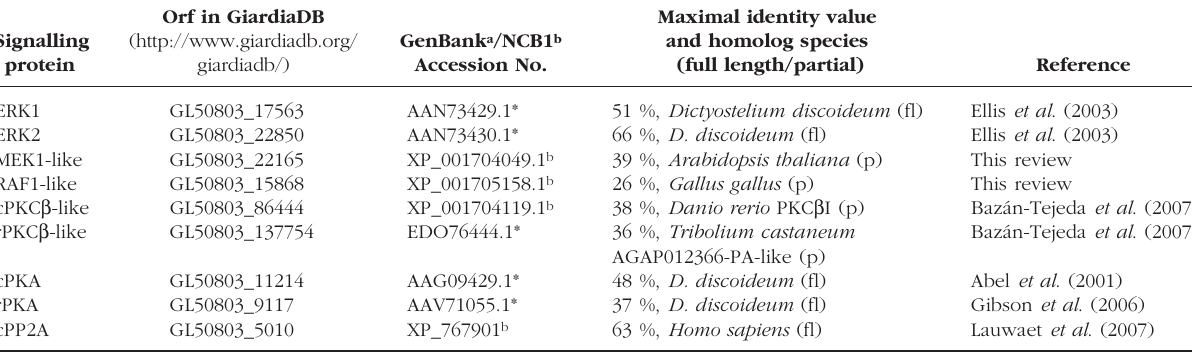
Table I. – Molecules proposed in the MAPK/ERK signalling pathway leading to SREBP activation during induction of G. duodenalis encysta- tion. (Fig. 3). Codes: Orf: open reading frame; c: catalytic subunit; r: regulatory